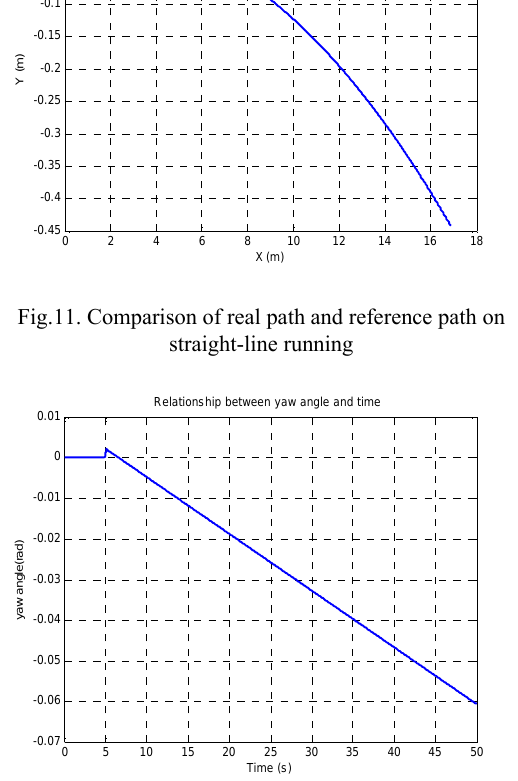
Fig.12. Relationship of yaw angle ψ and time